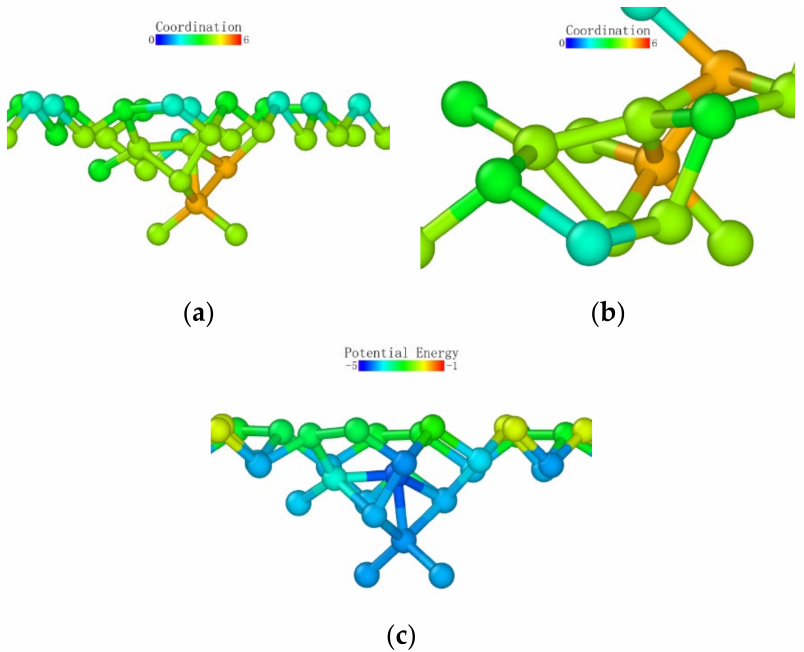
Figure 11. The bond structure when the stroke reached 0.4 nm: ( a , b ) colored according to the coordination number; ( c ) potential energy.